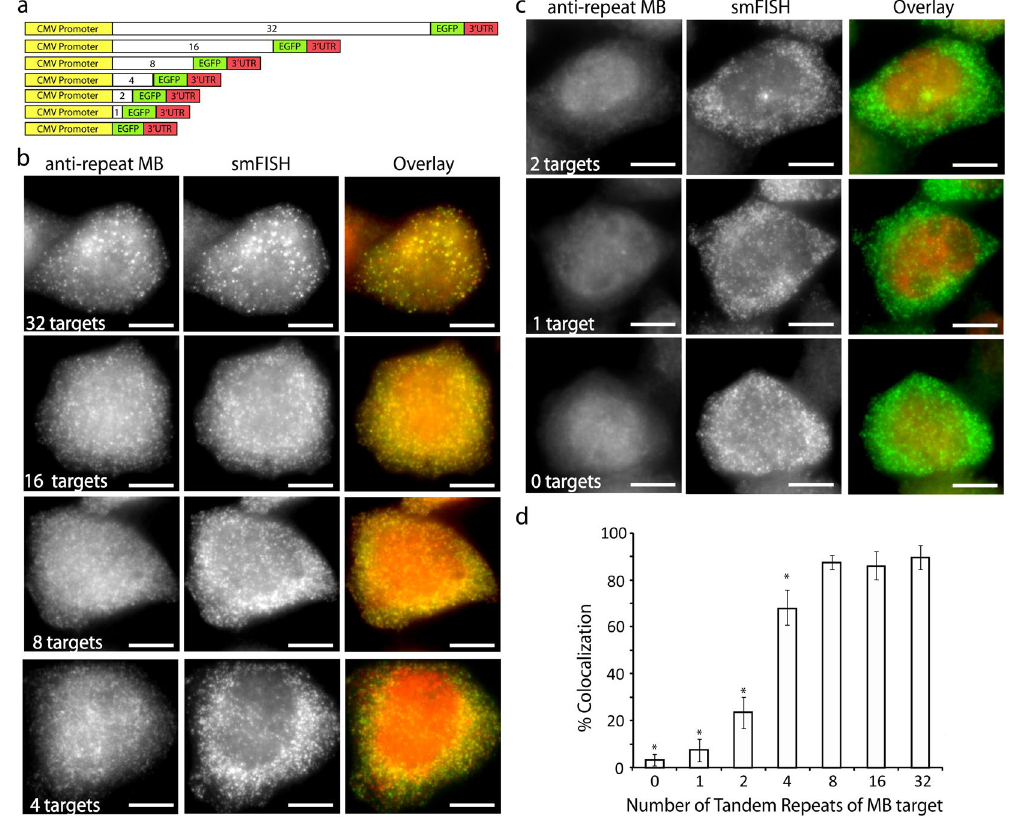
Figure 1. Detection of single RNA transcripts harboring different tandem repeats of MB binding sites using anti-repeat MBs and smFISH. ( a ) Scheme of the 7 constructs expressing EGFP with tandem repeat sequences inserted upstream of the EGFP gene. The MB targets and the EGFP mRNA are transcribed as one molecule. After microporation of HeLa cells expressing EGFP mRNA harboring different numbers of MB targets with 5 µ M anti-repeat MBs, the cells were fixed and permeabilized and smFISH was performed to assess the accuracy of MBs for detecting single RNA transcripts. Representative maximum intensity projection images of anti-repeat MBs (ATTO647N-labeled) and EGFP smFISH (TAMRA-labeled) in HeLa cells expressing EGFP engineered with ( b ) 32, 16, 8, or 4, and ( c ) 2, 1, or 0 tandem repeats of MB target sequence at 8 h are shown. (Scale bar, 10 µ m) ( d ) Accuracy of anti-repeat MBs for the detection of single RNA transcripts engineered with different numbers of MB binding sites. A custom Matlab program was written to analyze the percentage of MB signals that colocalized with smFISH signals. Data represent mean ± SD of at least 10 cells. * Represents significant difference from the 32-repeats